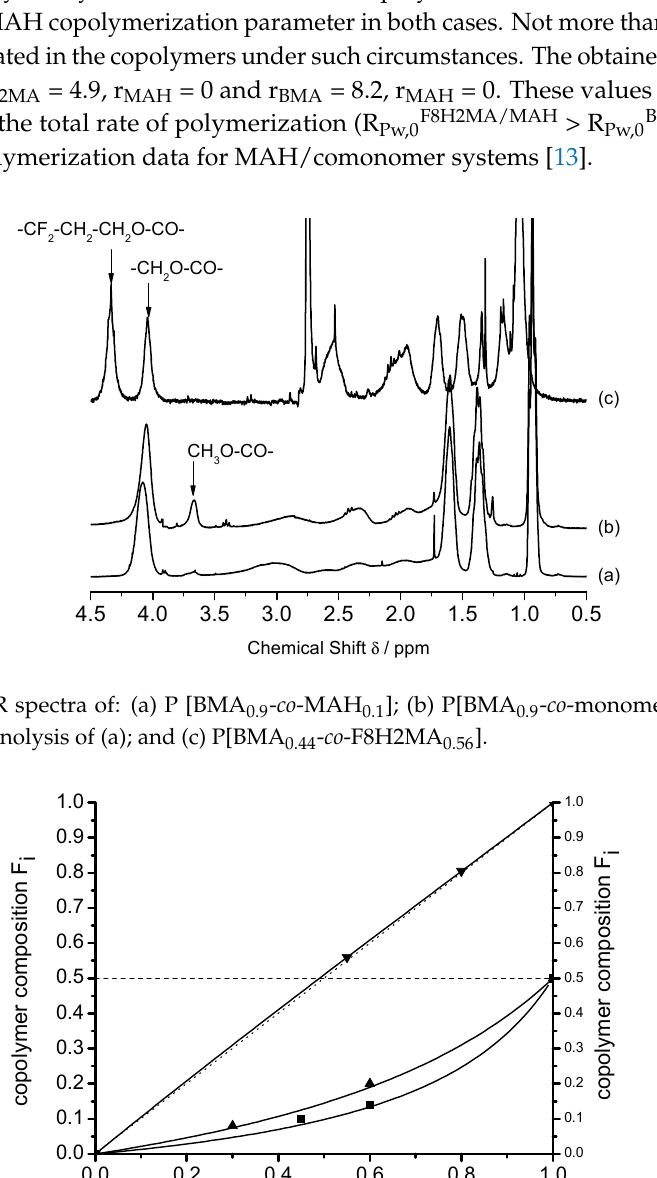
Figure 3. Copolymerization diagrams of the three binary systems F8H2MA/BMA ( (cid:72) , i = F8H2MA), MAH/F8H2MA ( (cid:78) , i = MAH) and MAH/BMA ( (cid:4) , i = MAH) at 65 °C.